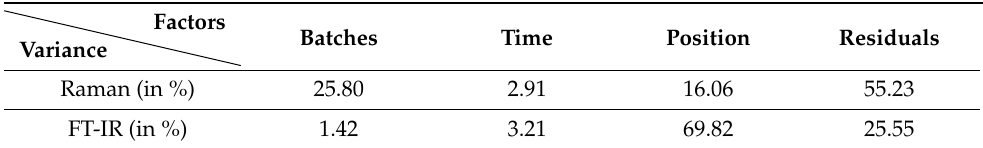
Table 2. Variance analysis of different factors from the plasma of the ischemic cardiomyopathy (ICM) patient ( n =